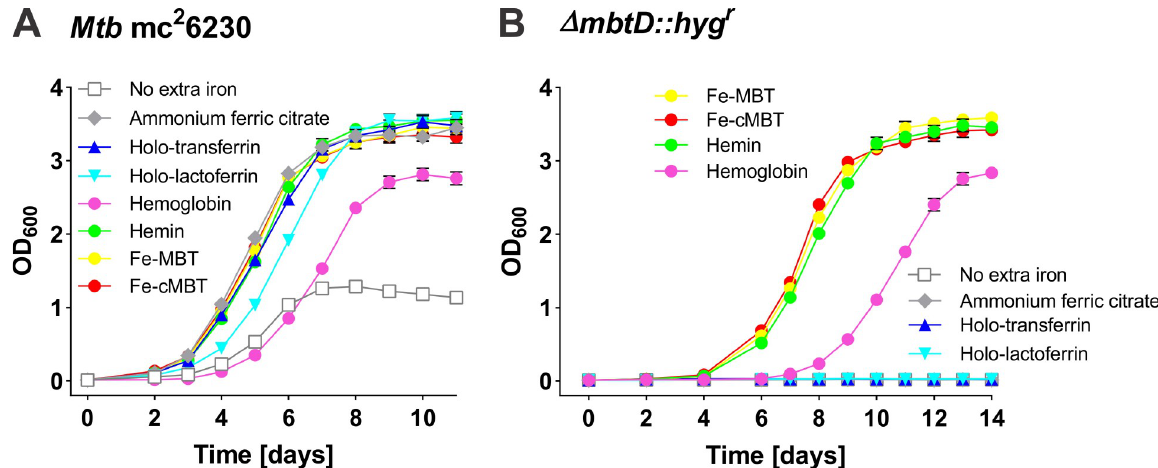
Fig 1. Growth of wild-type M . tuberculosis and of the Δ mbtD mutant with different iron sources. Growth of wild-type Mtb mc 2 6230 (A) and the Δ mbtD :: hyg r mutant (B) in self-made low-iron 7H9 medium supplemented with: 20 μ M ammonium ferric citrate; 10 μ M human holo- transferrin; 10 μ M human holo-lactoferrin; 5 μ M human hemoglobin; 20 μ M hemin; 0.2 μ M mycobactin (MBT) and 0.2 μ M carboxymycobactin (cMBT), respectively. The Mtb strains were grown in self-made low-iron 7H9 medium for 5 days to deplete intracellular iron before growth analysis. The initial OD 600 of all the cultures was 0.01. Error bars represent standard deviations from the mean results of biological triplicates.